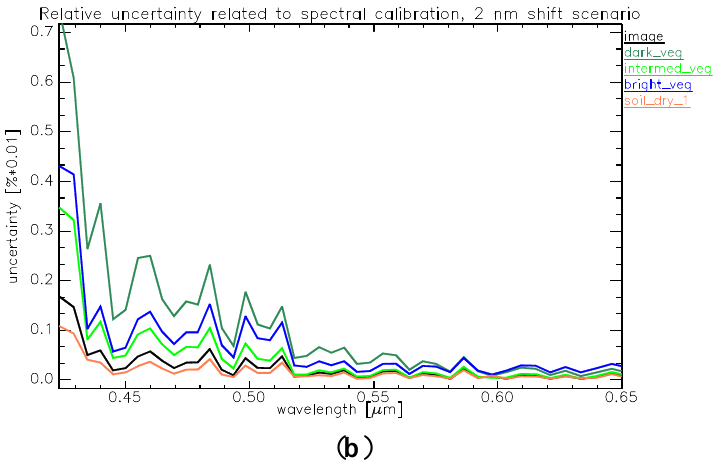
Figure 16. Plot of the relative standard deviation (stdev) for all ROI classes, representing the relative combined standard uncertainty of the 2.0 nm shift scenario; ( a ) full spectral range; ( b ) zoom on the wavelengths below 650 nm.